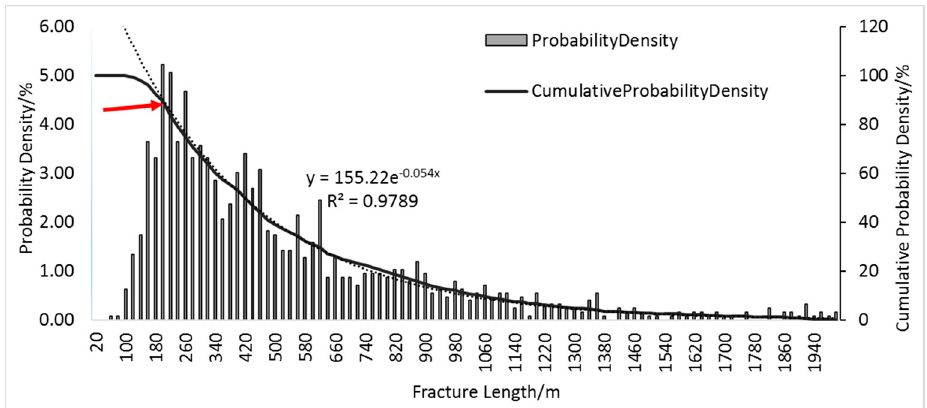
Figure 7. Distribution of the length of the extracted fractures. The distribution of fracture length corresponds the exponential law. The expression of the fitting curve is y = 155.22e − 0.054x , where x indicates the fracture length and y indicates the cumulative probability density.